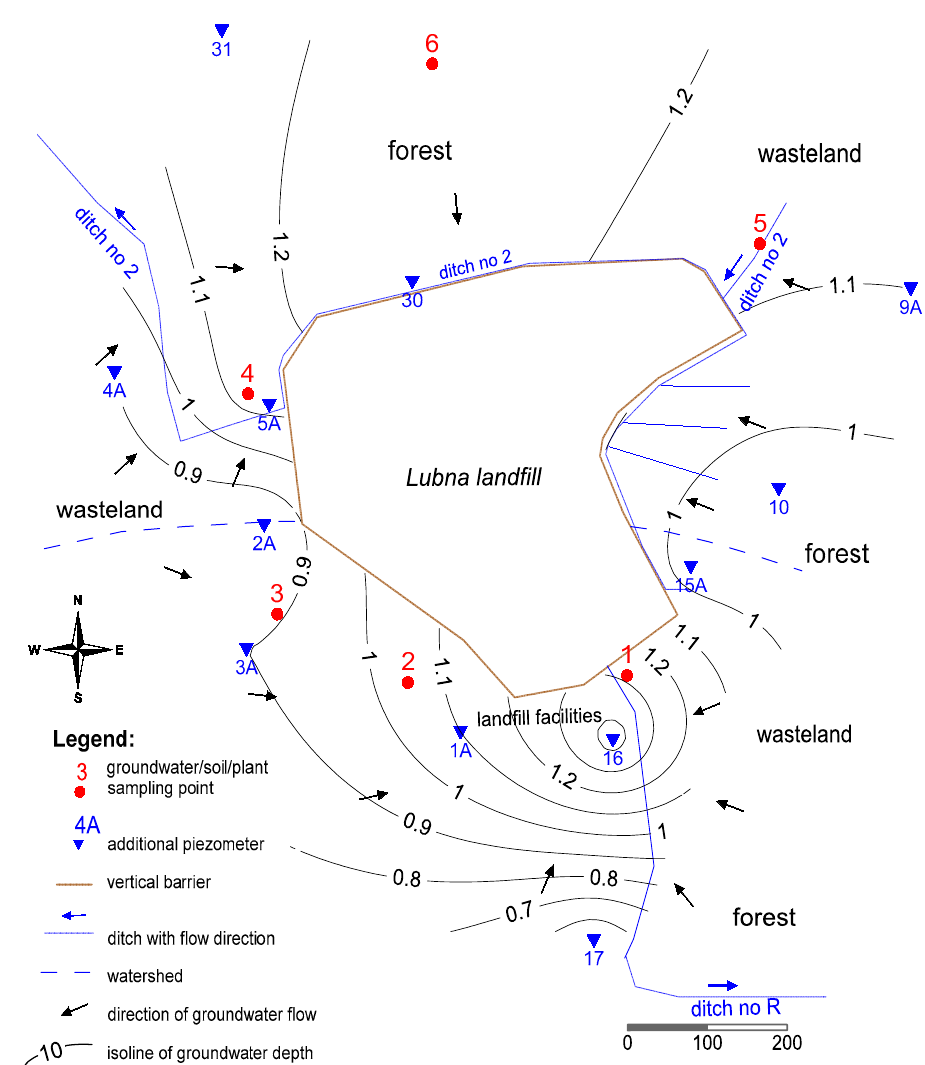
Figure 3. Location of the measurement points and additional piezometers with groundwater flow directions [15].